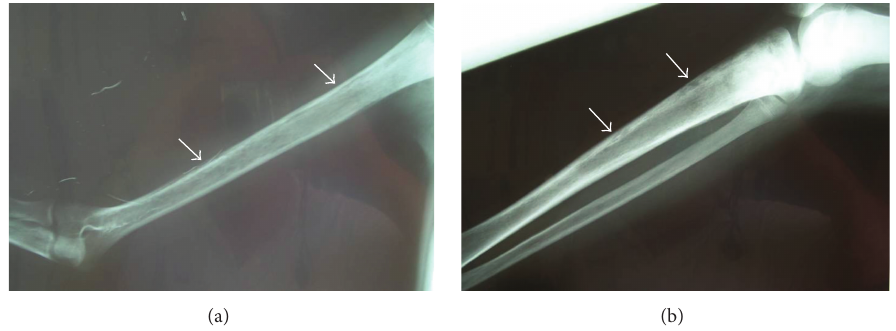
Figure 1: Diffuse osteolytic lesions in the right humerus ((a), arrows) and right tibia ((b), arrows).